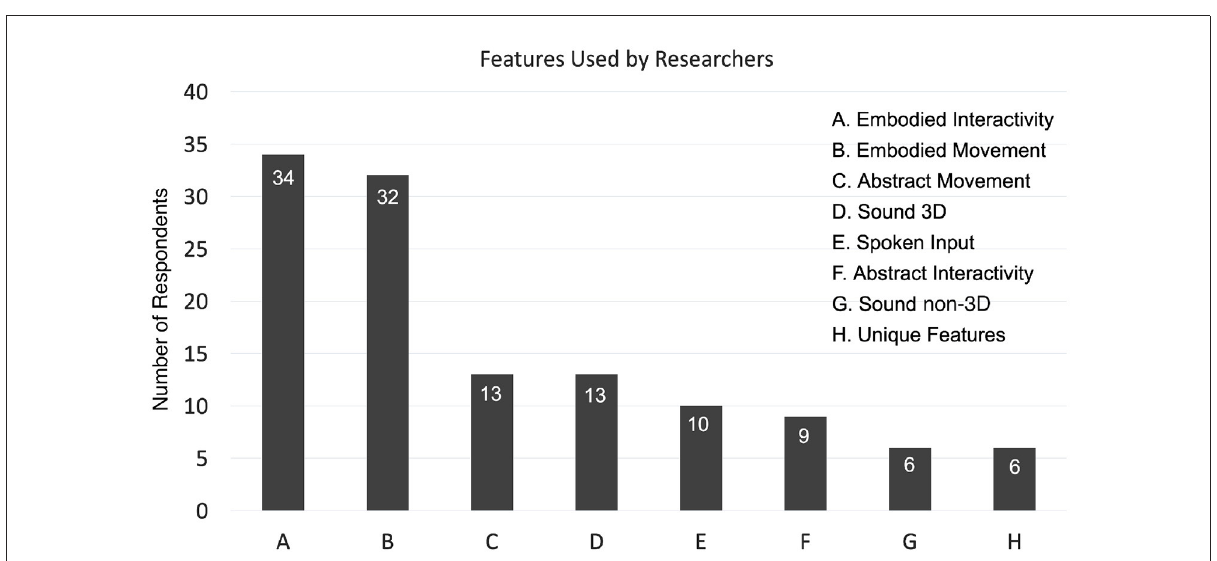
FIGURE2 Features used by respondents in their user studies. (A) Embodied Interactivity: using embodied controller/camera-based movement. (B) Embodied movement: Using your body to move/“roomscale”. (C) Abstract movement: Using a gamepad or keyboard and mouse to move. (D) Sound 3D: Binaural acoustics. (E) Spoken input. (F) Abstract interactivity: using a gamepad or keyboard and mouse to interact. (G) Sound non-3D: Mono/stereo audio. (H) Unique features: e.g., haptics, hand tracking,